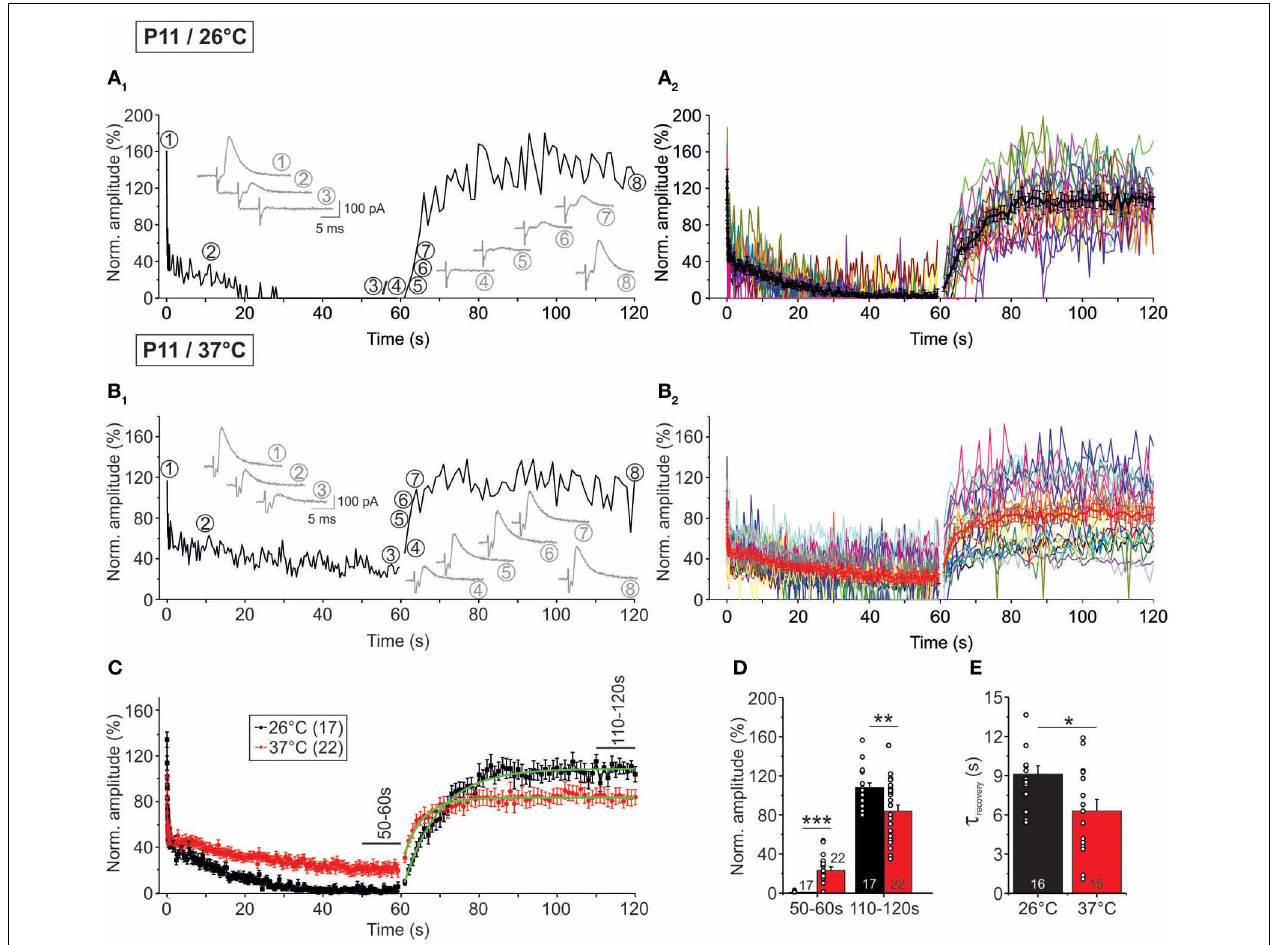
FIGURE 9 | Temperature dependency of STD and recovery of IPSC peak amplitudes at P11. Neurons were stimulated with 50Hz for 60s (depression phase) and subsequently stimulated with 1Hz for another 60s (recovery phase). (A 1 , B 1 ) TimecourseoftheIPSCpeakamplitudesoftworepresentative LSO neurons at 26 ◦ C (A 1 ) and 37 ◦ C (B 1 ) . Insets show eight original IPSCs at the positions marked by encircled numbers. (A 2 , B 2 ) , Time course of the IPSC peak amplitudes of all recorded neurons. Mean values ± s.e.m. are shown in black( A 2 :26 ◦ C, n = 17)andred( B 2 :37 ◦ C, n = 22).Themeanvaluesrepresent the simple moving average of five data points, thus smoothing out short-term